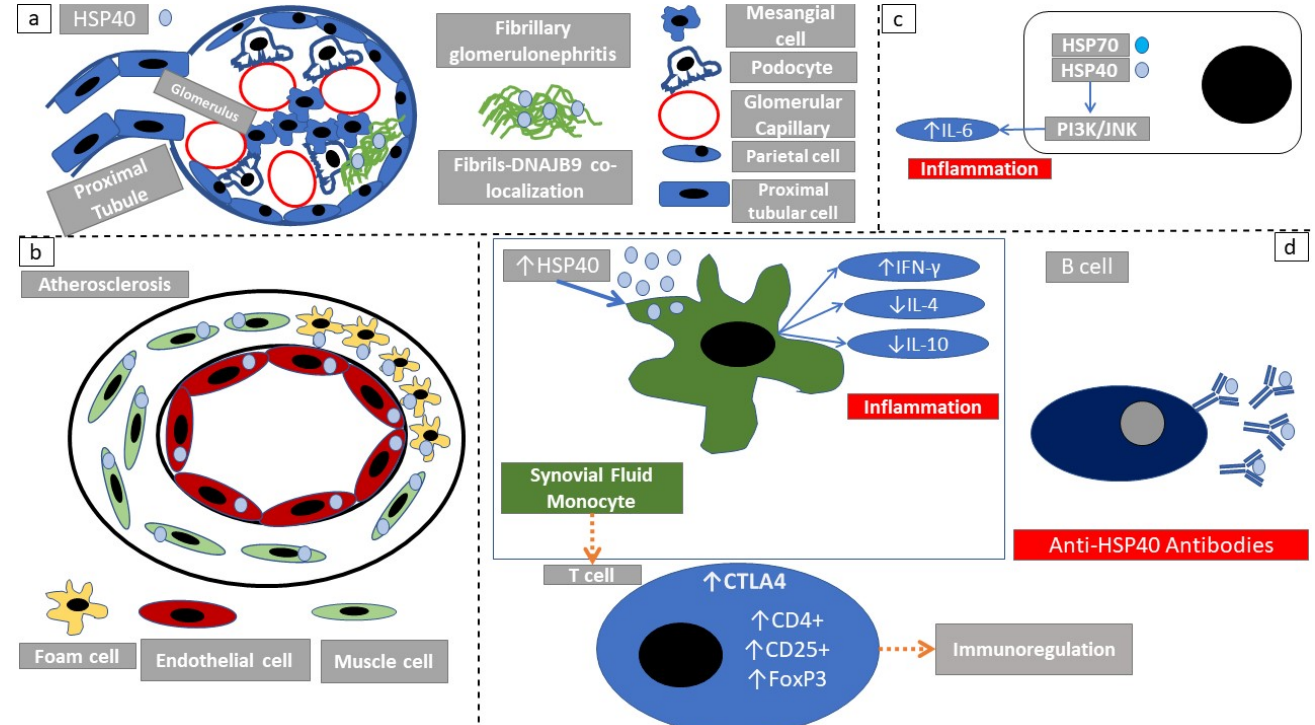
Figure 3. Immunomodulatory actions of HSP40. ( a ) HSP40 is a biomarker of fibrillary glomerulonephritis. The fact that DNAJB9 colocalizes with fibrils, depicts that HSP40 protein family members have an extracellular function. ( b ) In atherosclerosis, HSP40 is highly expressed in atheromatous lesions. More specifically cellular components that actively participate in atheroma formation express high amounts of HSP40. ( c ) HSP40/HSP70 complexes induce PI3K/JNK signaling and inflammation. ( d ) HSP40 exerts a bimodal action. Antigen-presenting cells exposed to HSP40 induce an inflammatory response through increased IFN γ production. However in a later phase, there is an expansion of tolerogenic T-regulatory cells.